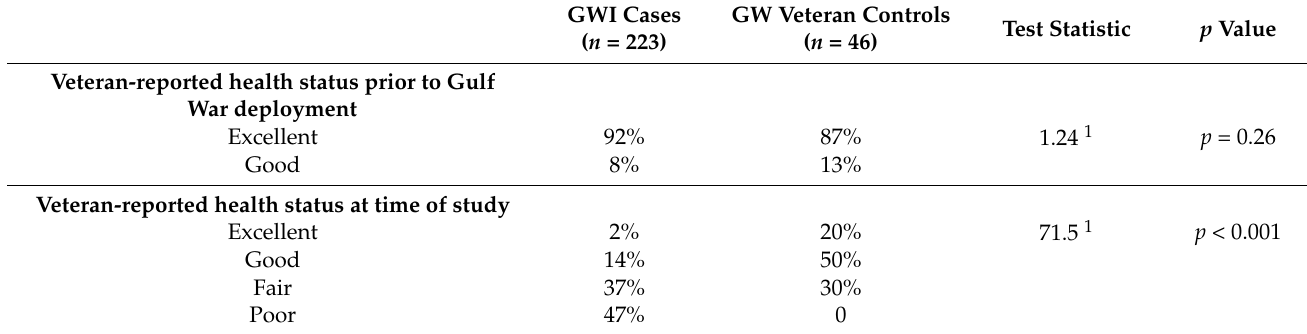
Table 2. General health characteristics of GWI cases and